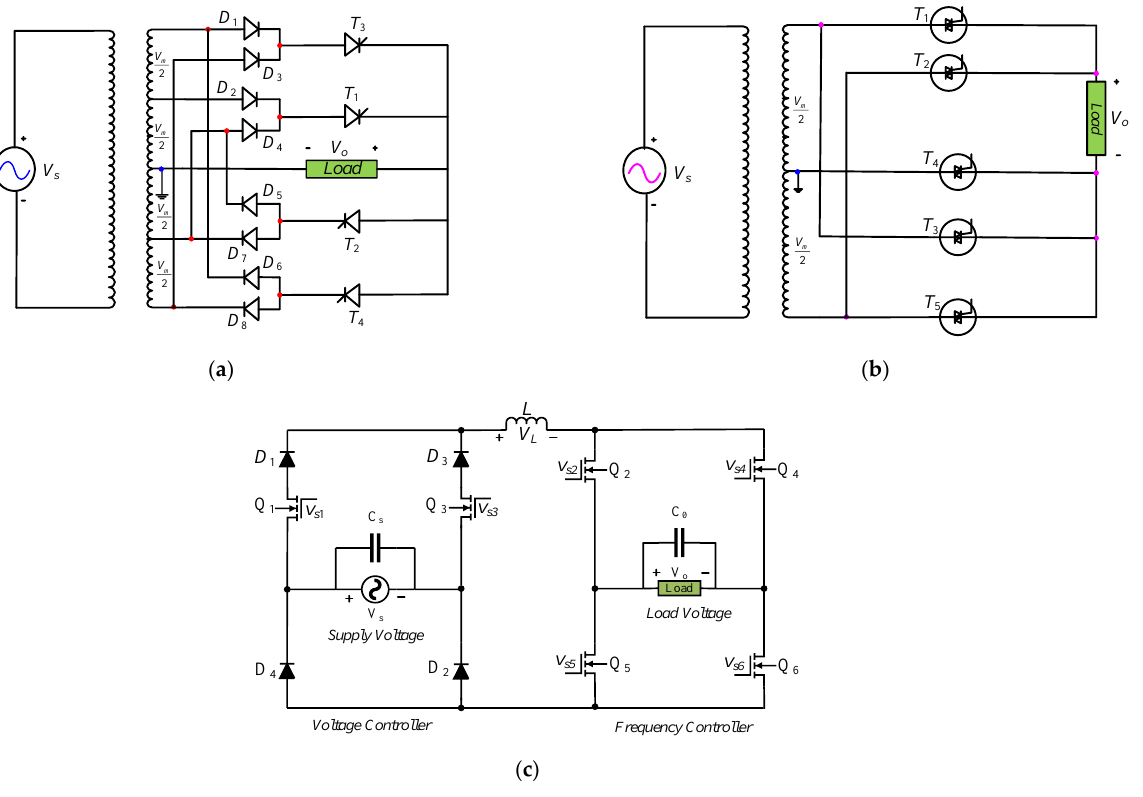
Figure 2. Various frequency converters with voltage adjustment control: ( a ) multi-winding transformer-based approach; ( b ) center tape transformer-based approach; ( c ) transformerless approach.